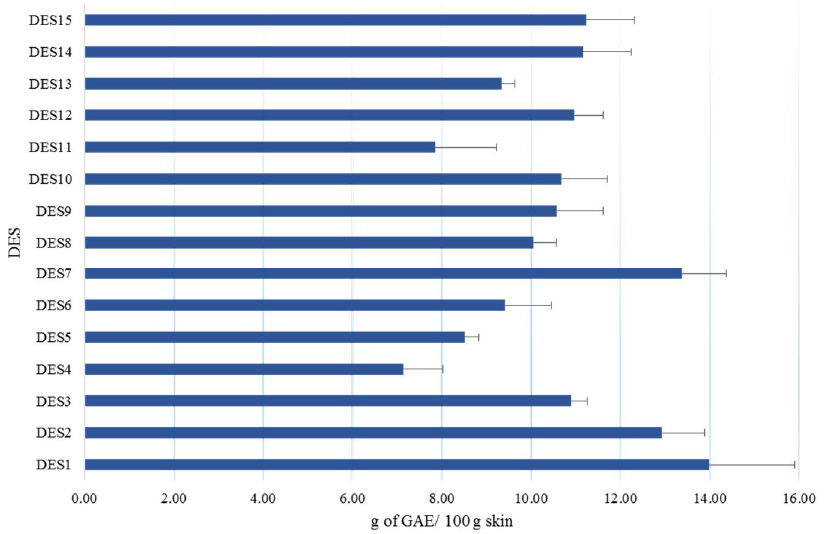
Figure 1. Effect of DES composition (Table 1) on the extraction efficiency of phenolic compounds.